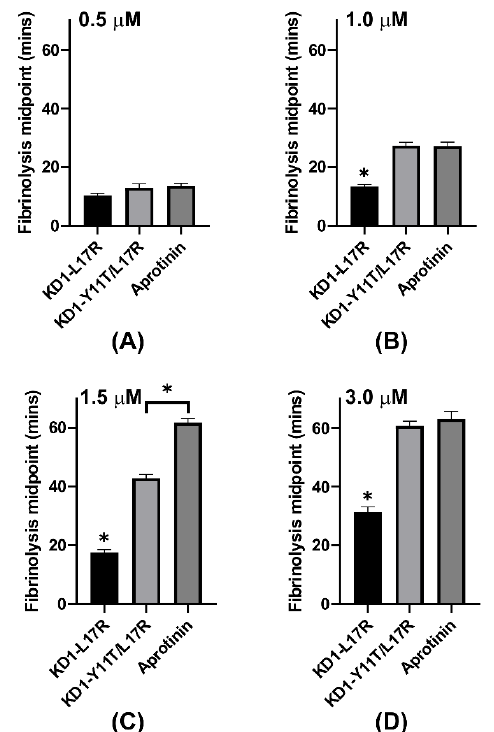
Figure 6. Comparison of the fibrinolysis midpoints for KD1-L17R-K COOH , KD1-Y11T/L17R-K COOH and aprotinin at various concentrations used (( A ), 0.5 µ M; ( B ), 1.0 µ M; ( C ), 1.5 µ M; and ( D ), 3.0 µ M) in the plasma clot lysis assay. Bar graphs are presented displaying time (minutes) to reach fibrinolysis midpointswithKD1-L17R-K COOH , KD1-Y11T / L17R-K COOH andaprotininattheindicatedconcentration. Concentration of each inhibitor used is indicated for each panel. All experiments were performed in triplicate and the mean ± SD values are presented. Note: The * without bar represents significant difference from all other agents listed. The * indicates p < 0.05.